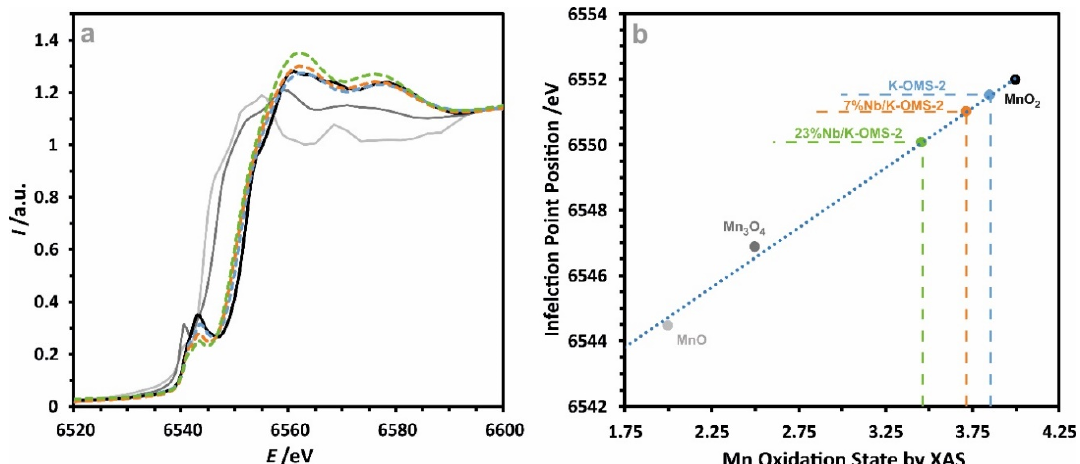
Figure 5. X-ray absorption spectra of the bare and Nb-doped sample with 7 and 23% loading together with the reference spectra of MnO (light gray), Mn 3 O 4 (gray), and MnO 2 (black), respectively ( a ), and the correlation between the inflection point of the XAS spectra versus Mn average oxidation state ( b ). The average Mn oxidation states obtained for the bare (blue) and doped Nb 7 wt% (orange) and 23 wt% (green) samples is marked by the dashed lines.